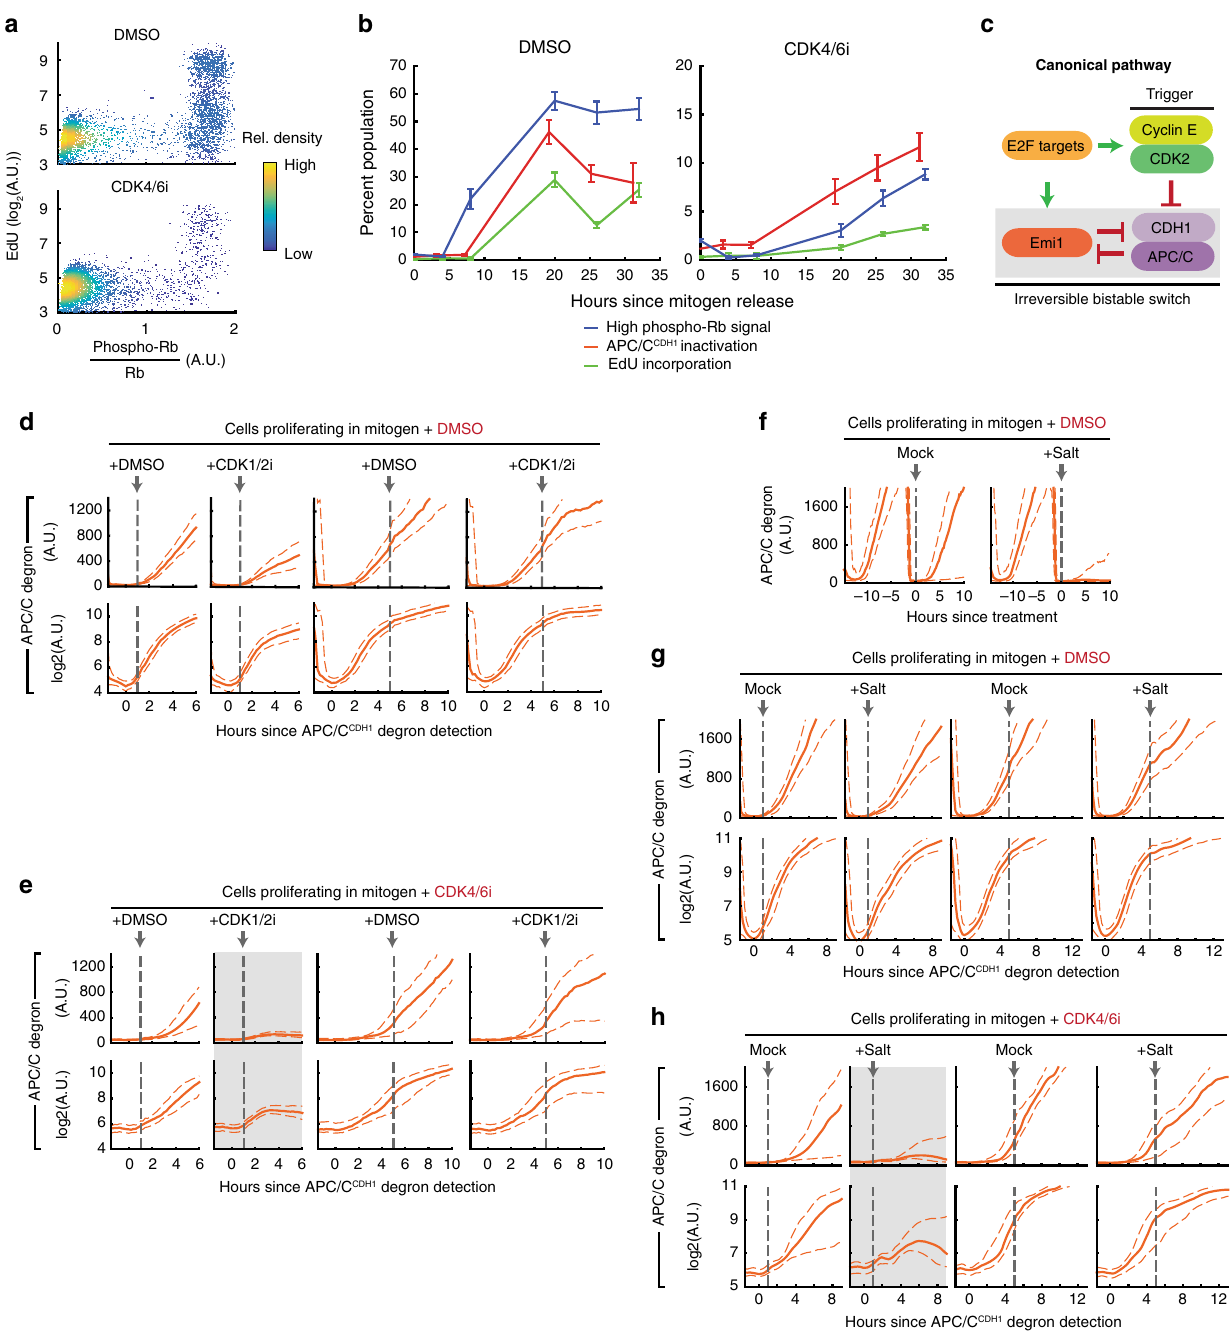
Fig. 6 APC/C CDH1 inactivation remains reversible until Rb inactivation in cells lacking CDK4/6 activity. a Cells born into DMSO or 1 µ M CDK4/6 inhibitor were treated with 10 µ M EdU for 15 min, and then assayed for EdU and phospho-Rb(S807/S811) (5000 cells plotted, 1 of n = 3 biological replicates). b Mitogen-released cells treated with DMSO or CDK4/6 inhibitor were measured for percent cells with high phospho-Rb(S807/S811) signal, high APC/C degron, and high EdU signal (after 15 min of 10 µ M EdU treatment). Mean± SEM from three biological replicates. c Emi1 ensures irreversible APC/C CDH1 inactivation. d – h Cells born into DMSO or CDK4/6 inhibitor and have inactivated APC/C CDH1 (with the exception of ( f ), where it is just cells born into DMSO or CDK4/6 inhibitor) were treated with 3 µ M CDK1/2i ( d , e ) or an extra 100 mM salt ( f – h ). Dashed lines denote 25th and 75th percentile and bottom row panels are plotted in log 2 scale for better visualization. APC/C degron detected via signal over background. Gray boxes denote conditions where cells reactivated APC/C CDH1 . n = 2 biological replicates; n > 30 cells per condition. In g , h , to enrich for Rb inactivated cells in the 5 h post APC/ C CDH1 degron detection conditions, only cells with cyclin E/A-CDK>0.8 right before treatment were analyzed (threshold determined from Fig.